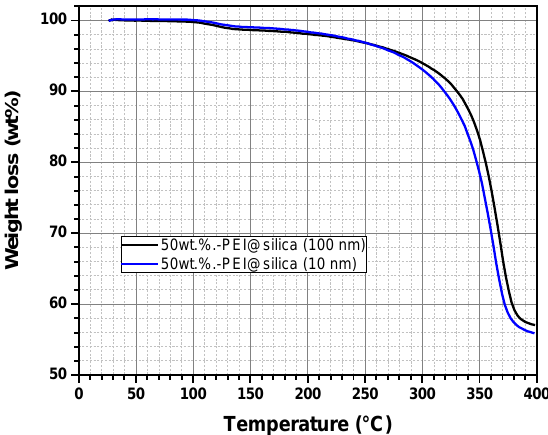
Figure 3. Thermogravimetric analysis (TGA) of the sensing material PEI@silica ( a ) under Argon flux. The hybrid materials, PEI@silica ( 10 nm ) and PEI@silica ( 100 nm ), show the same decomposition behavior, which is dependent on the temperature but independent on the size of the used silica.